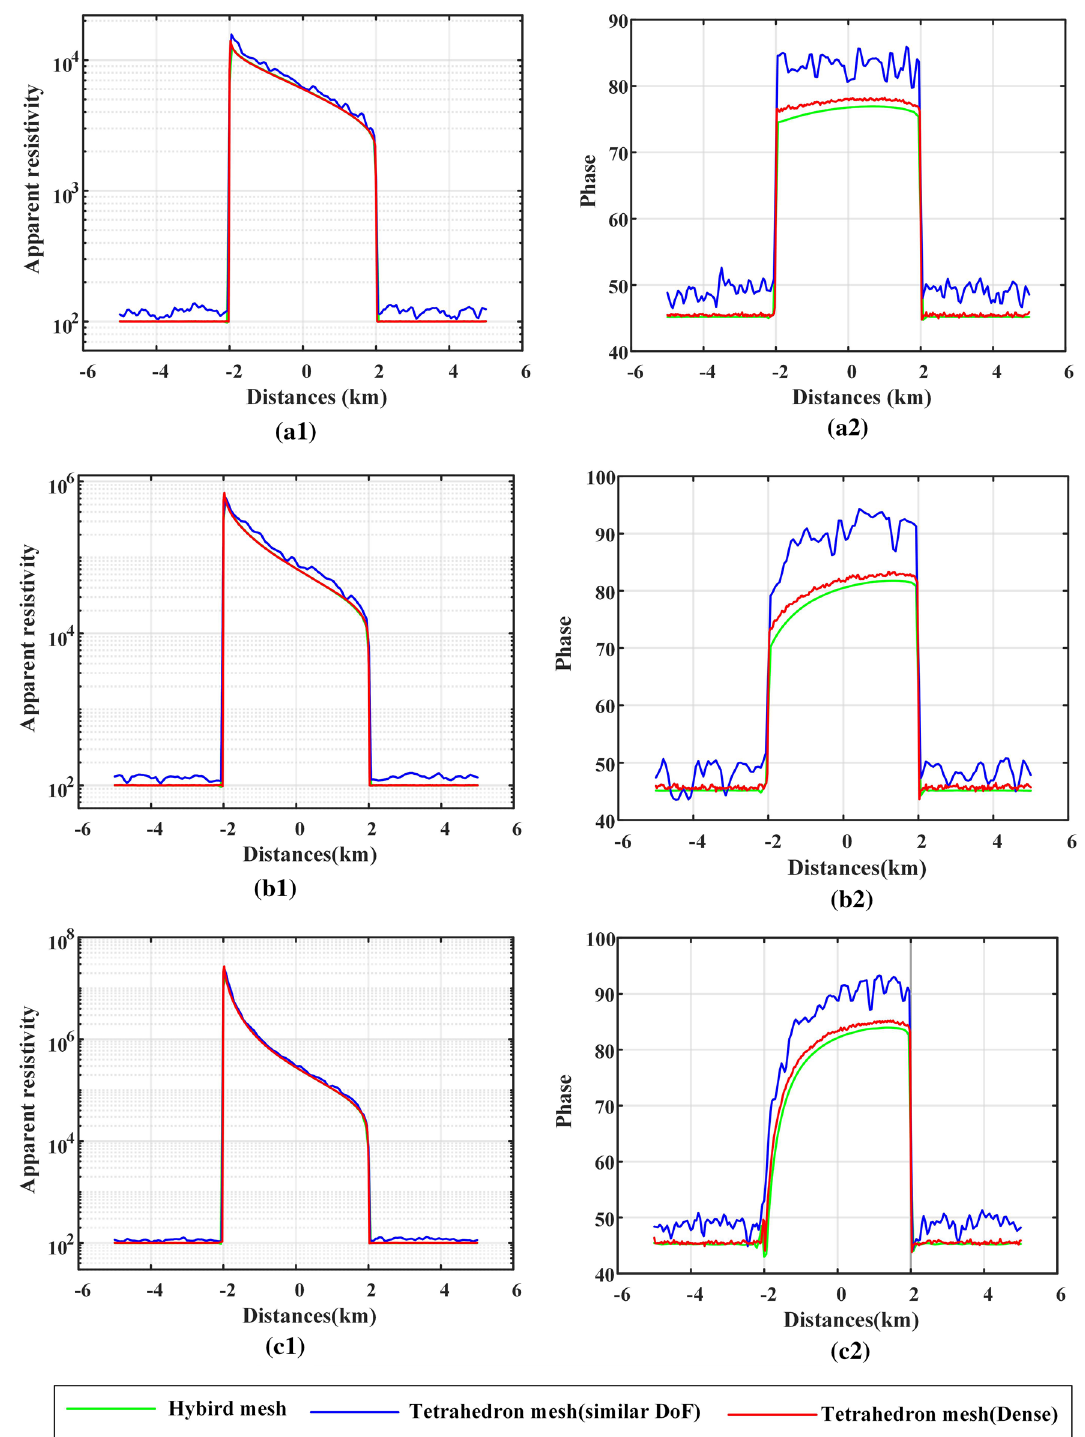
Figure 13. For the sloped terrain model, when the tilt angle changes, the MT response results of the xy component are calculated by different meshes. ( a 1), ( b 1) and ( c 1) represent the calculation results of the apparent resistivity, and ( a 2), ( b 2) and ( c 2) represent the calculation results of the phase. ( a ), ( b ) and ( c ) represent the calculation results when the tilt angle is 10, 20, and 30 degrees,